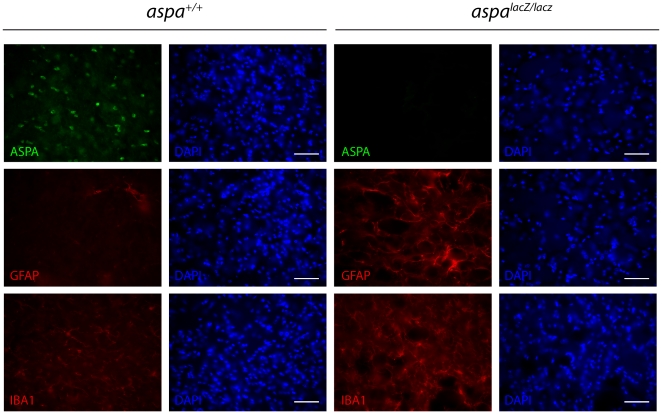
Reactive gliosis in aspalacZ/lacZ mice.Immunohistochemical staining in the thalamus of aspa+/+ controls and aspalacZ/lacZ mice showed substantially increased numbers of GFAP-positive astrocytes and Iba-1-positive microglia in the mutants (at 3 months of age). Note that ASPA immunoreactivity is present in the control but not in the mutant. Bars: 25 µm.